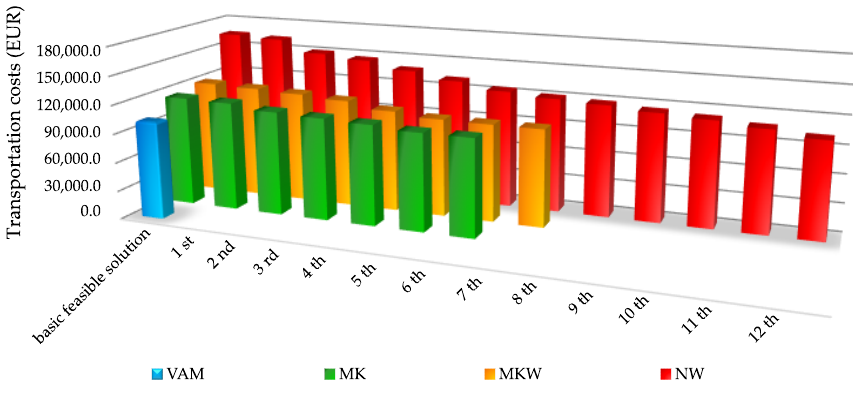
Figure 5. Next improvements of solutions.